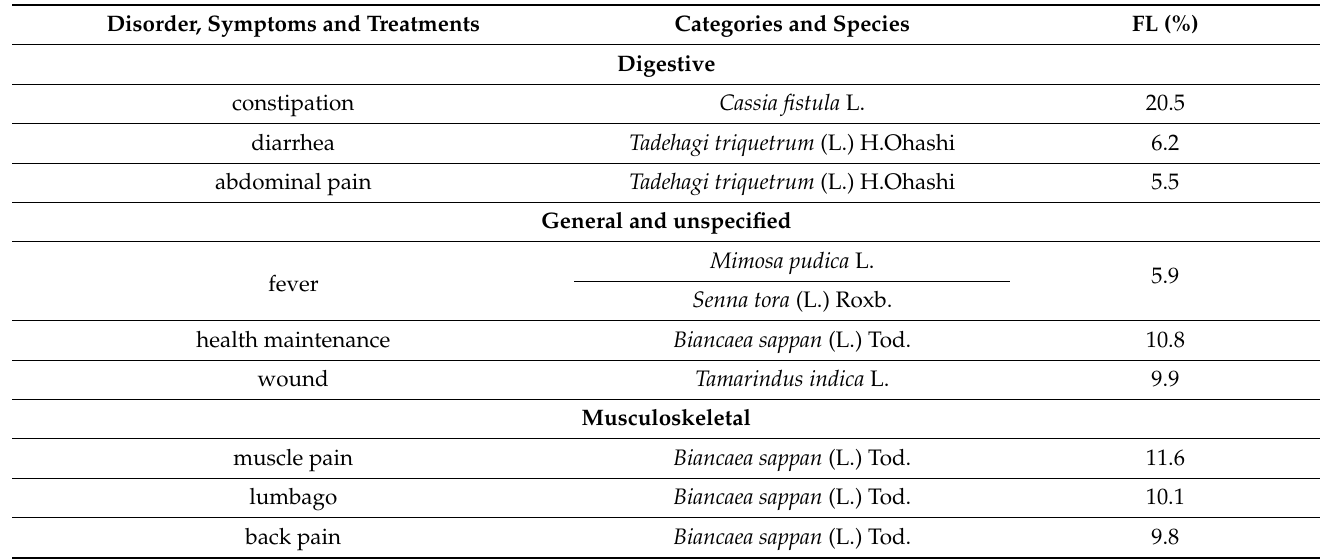
Table 3. Thai legume species with the highest fidelity level values that were used to treat the most common disorders within top three categories with highest ICF values, derived from 152 studies of traditional medicine in Thailand published from